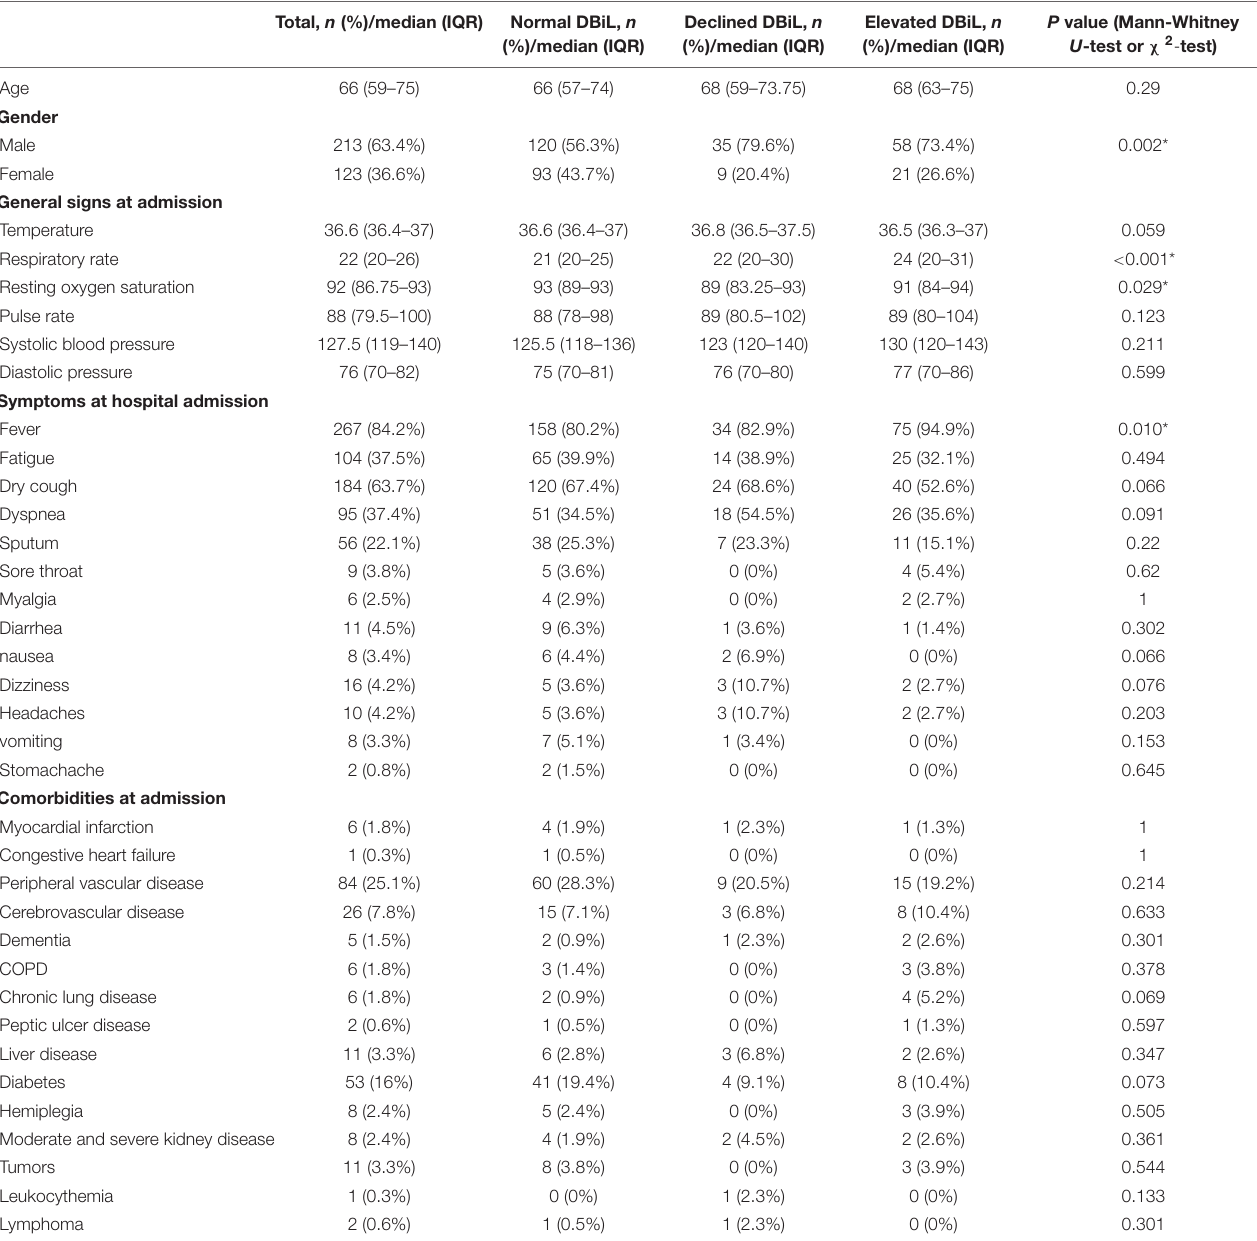
TABLE 1 | Basic demographic characteristics, general signs, symptoms and comorbidities of 337 COVID-19 severe/critically ill